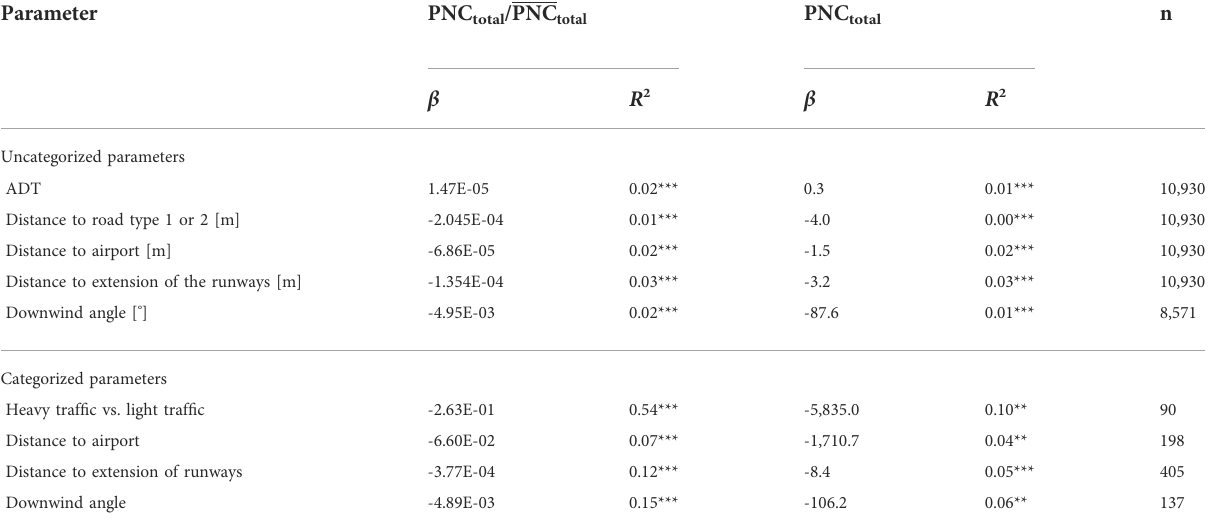
TABLE 4 Correlations for PNC total /PNC total and PNC total [cm − 1 ] for road traf fi c and airport operation parameters including regression coef fi cient β , coef fi cientofdetermination R 2 ,andsamplesize n .Uncategorizedparameters:PNCattrackpointsiscorrelatedwiththeparameters.Categorized parameters: mean PNC is calculated per run and